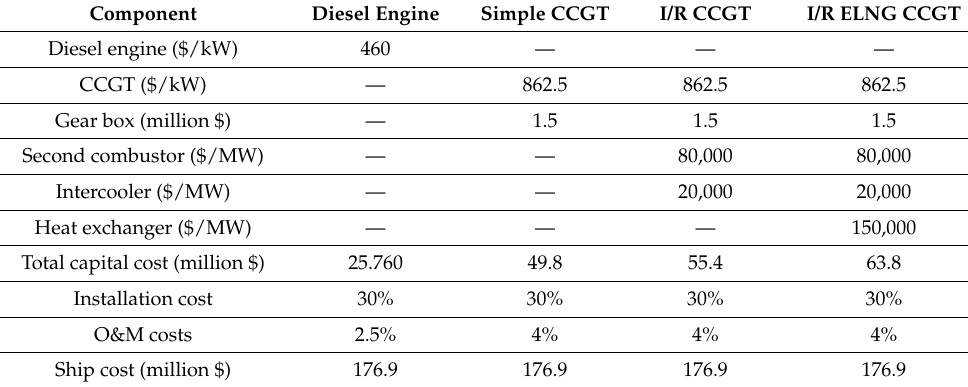
Table 2. Costs of CCGT components and two-stroke diesel